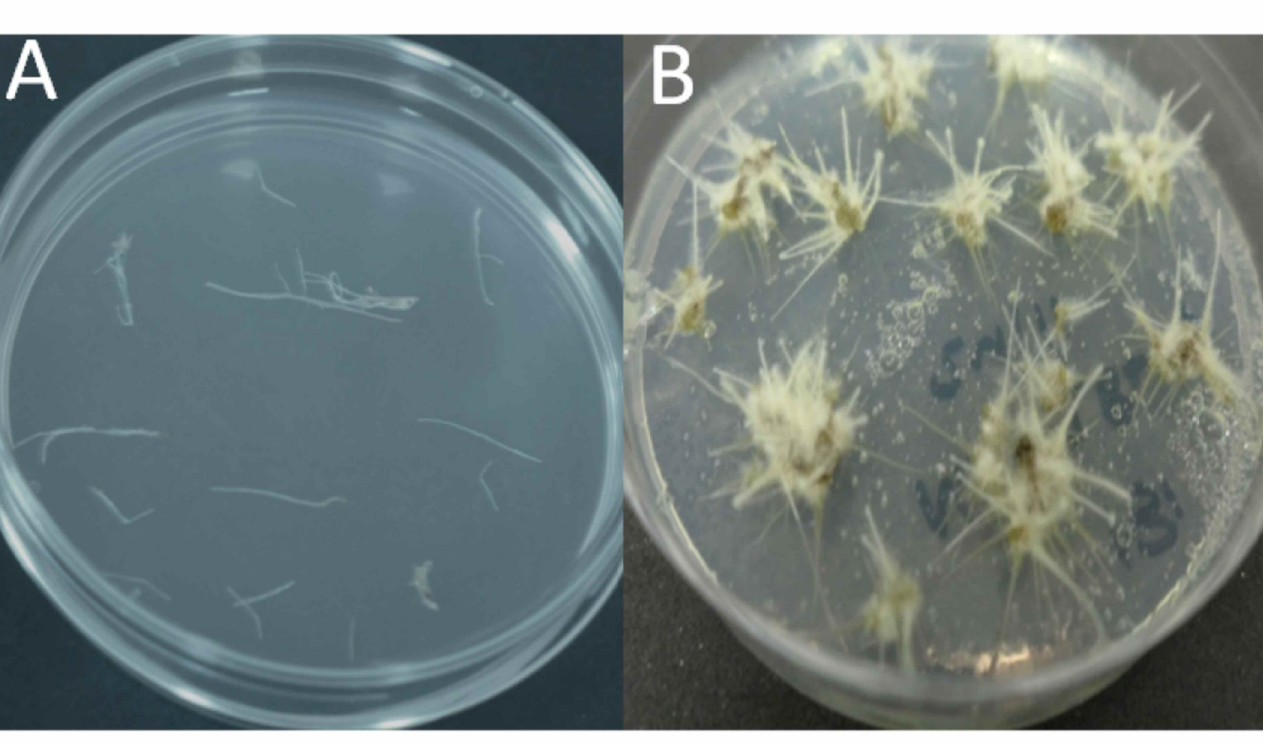
FIGURE 6 - Four-week-old root clones on the kanamycin selection medium. Not developing root fragments taken from the control, not transformed plant (A), intensively growing hairy root clones obtained from explants transformed with the A4 A. rhizogenes strain